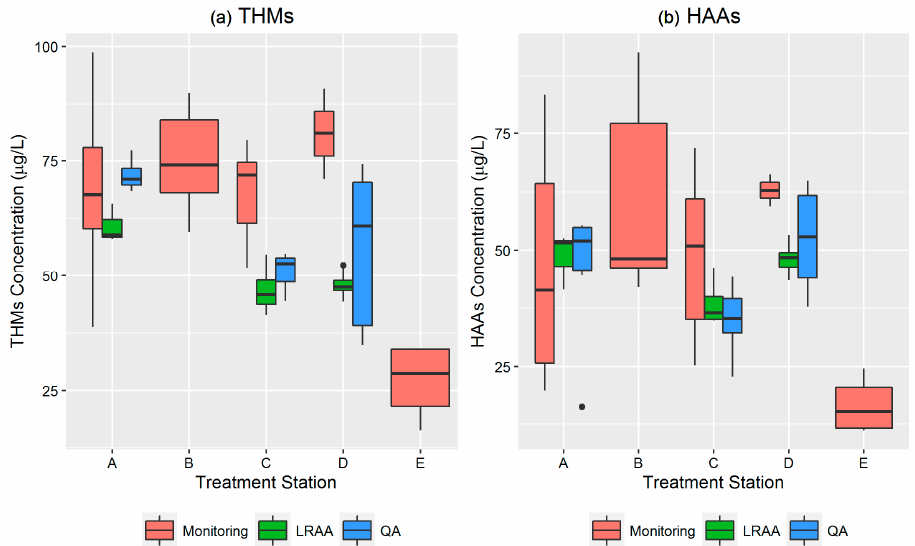
Figure 3. Spatial comparison of monitored ( a ) total THMs and ( b ) HAAs levels with LRAA compliance and QA data. The boxplots above utilize Tukey-style whiskers in that the upper whisker extends from the upper hinge (75th percentile) to the highest value that is within 1.5 × IQR (interquartile range) of the hinge and the lower whisker extends from the lower hinge (25th percentile) to the lowest value within 1.5 × IQR of the hinge. The black dots are outlier data points (outside the 1.5 × IQR range).